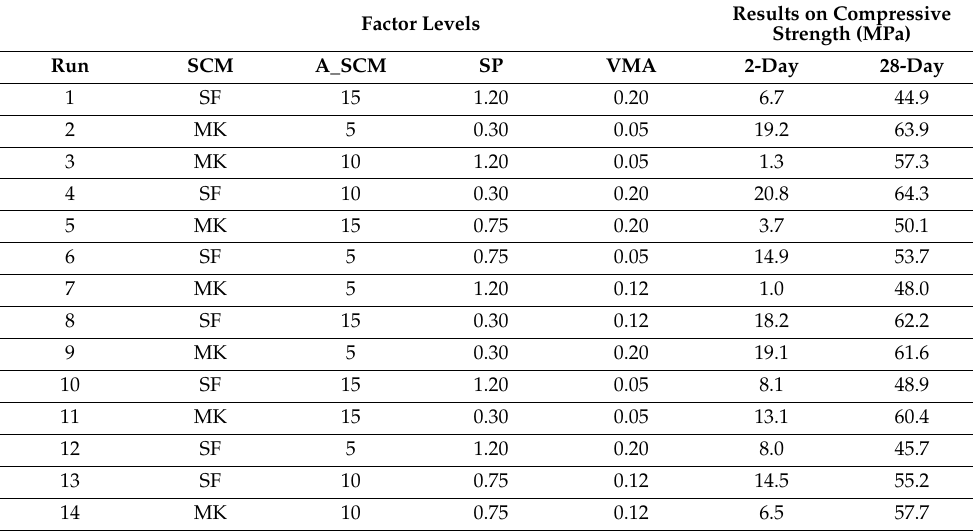
Table 8. Design matrix and results on 2- and 28-day compressive strength. Factor Levels